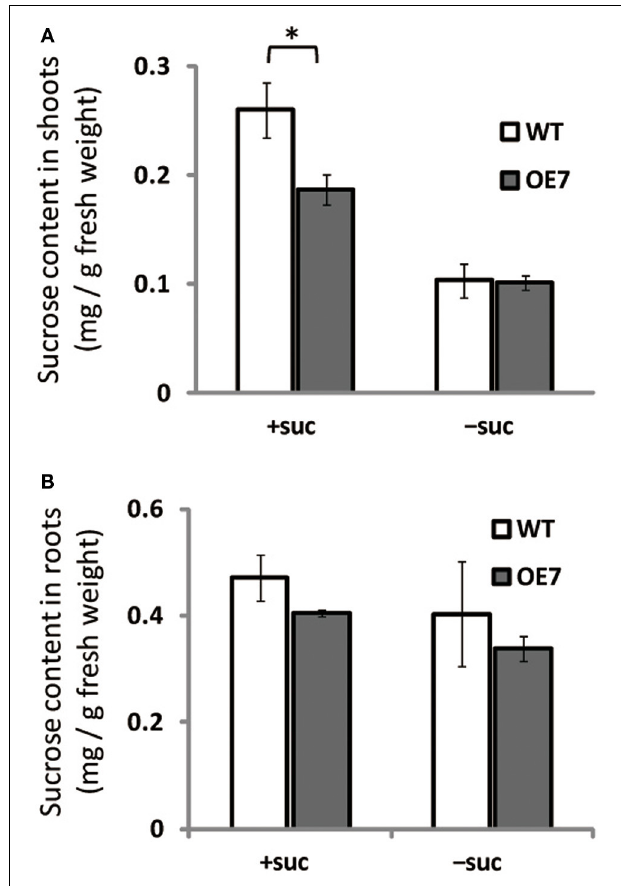
FIGURE 8 | Sucrose content in WT and OE7 seedlings grown with or without exogenous sucrose. Plants grown on MS medium supplemented with + suc or − suc for 7d were then transferred to ½MS agar with or without sucrose, respectively, and grown for another 7d. (A) Sucrose content in shoots. (B) Sucrose content in roots. Values represent the mean ± SE [ n = 6 (shoot, + suc), n = 5 (shoot, − suc), n = 3 (root, + suc and − suc)]. ∗ P < 0 .